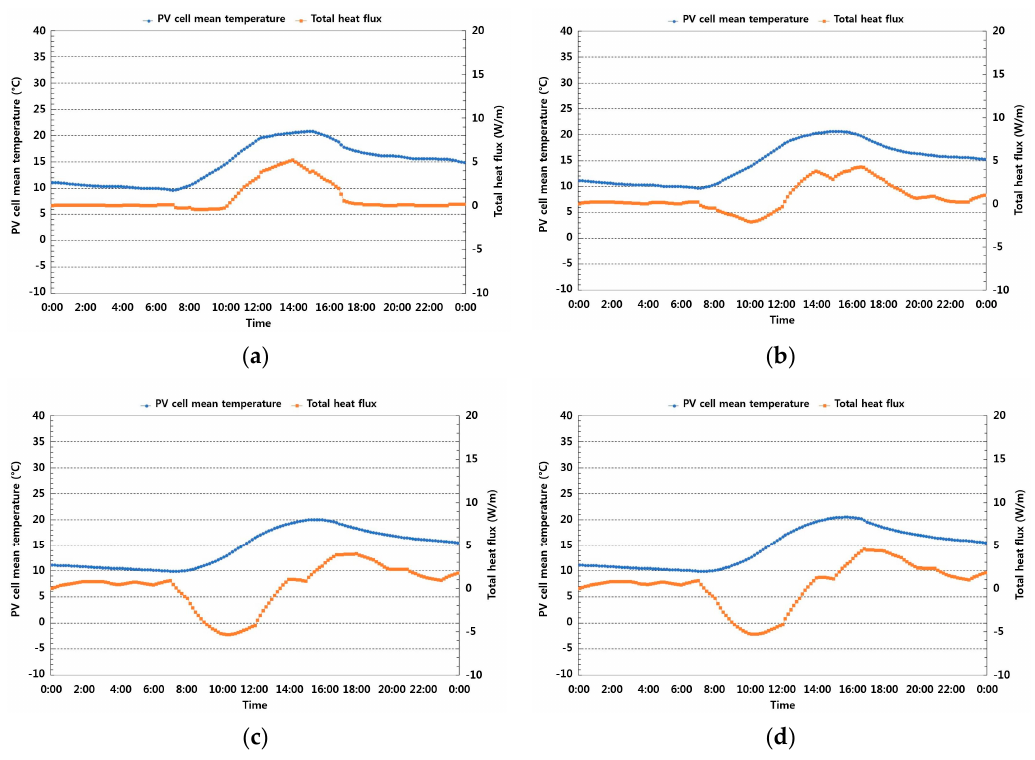
Figure 8. Comparison of mean operating temperatures of PV cell and total heat flux from panel to surrounding under the cloudy sky and moderate temperature (intermediate season): ( a ) Case1; ( b ) Case2 PCM1; ( c ) Case2 PCM2; and ( d ) Case3 PCM2.